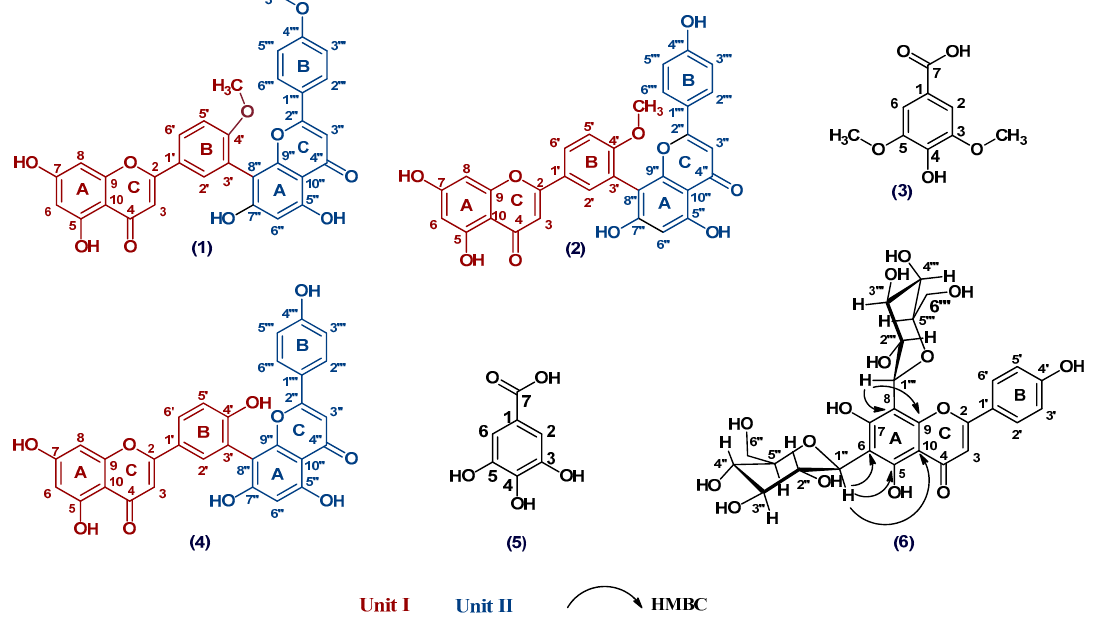
Figure 3. Structures of the compounds ( 1 – 6 ) isolated from the n -BuOH fraction of Z. floridana A.